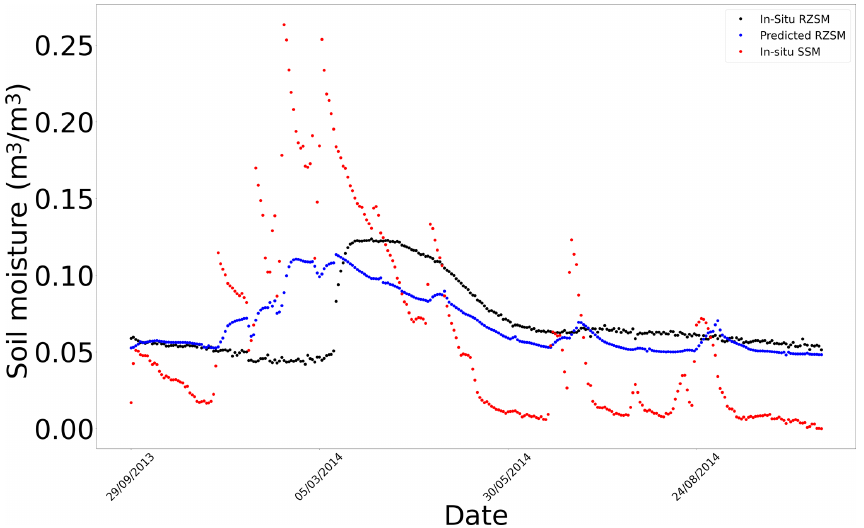
Figure F2. In situ SSM, in situ RZSM, and predicted RZSM series at station Lind#1 with model ANN_SSM_NDVI_EVAP-EFF-B60_EXP-